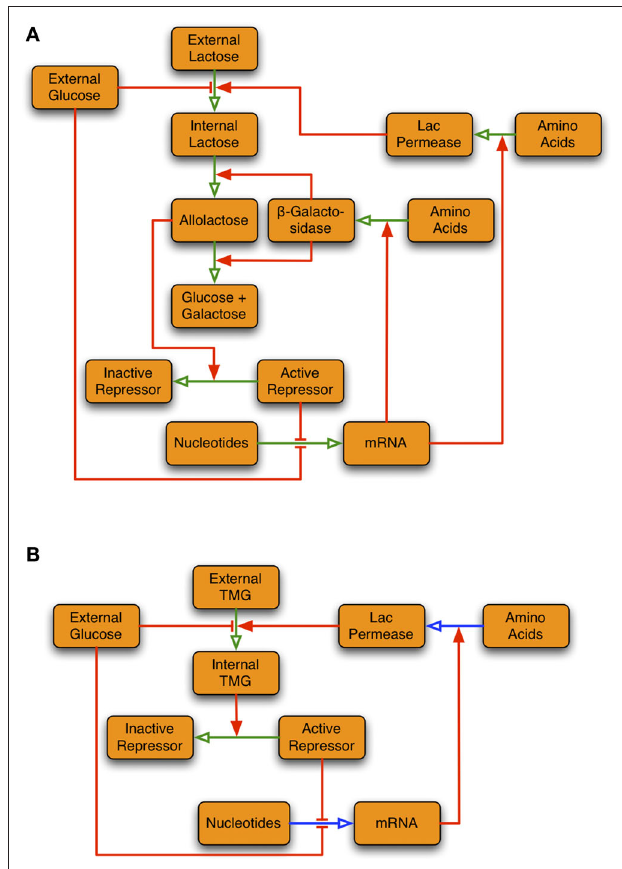
Figure 2 | Schemes representing the lac operon regulatory pathways when the system is induced with lactose (A), and when it is induced with an artificial inducer like TMG (B). Labeled rectangles represent chemical species, arrows with empty heads denote processes through which one chemical species is transformed into another, arrows with solid heads indicate interactions that enhance the process they point to, and finally, lines ending in perpendicular bars denote interactions that diminish the process they point